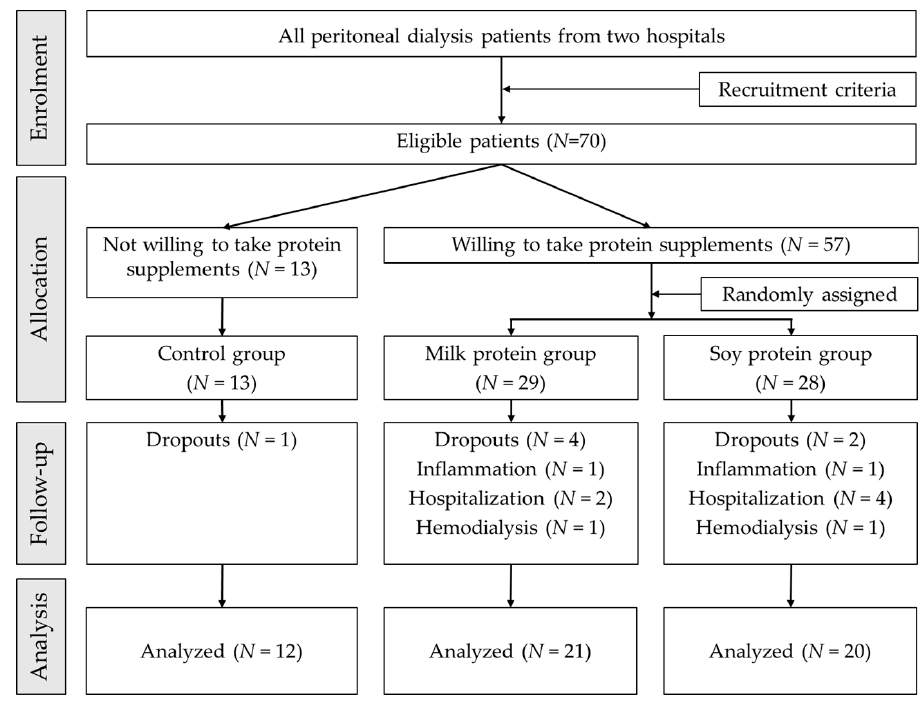
Figure 1. Study flowchart.